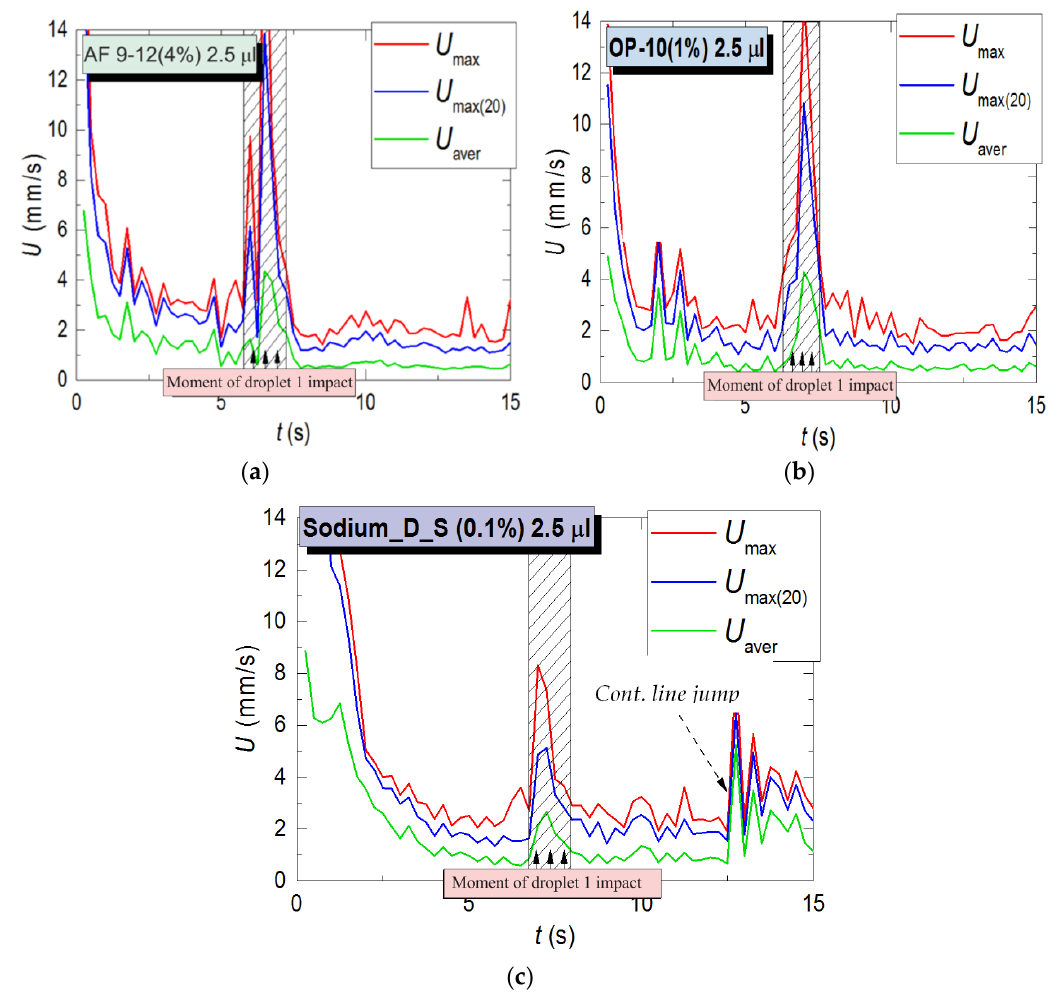
Figure 8. ( a ) The behavior of U max , U max(20) , and U aver at falling of droplet 1 ( V 01 = 2.5 µ L; water + surfactant AF 9-12; 4% mass) on sessile drop 2 ( V 02 = 40 µ L; T w = 80 ◦ C; water); ( b ) the behavior of U max , U max(20) , and U aver at falling of droplet 1 ( V 01 = 2.5 µ L; water + surfactant OP-10; 1% mass) on sessile drop 2 ( V 02 = 40 µ L; T w = 80 ◦ C; water); ( c ) the behavior of U max , U max(20) , and U aver at falling of droplet 1 ( V 01 = 2.5 µ L; water + surfactant Sodium DS; 0.1% mass) on sessile drop 2 ( V 02 = 40 µ L; T w = 80 ◦ C; water).